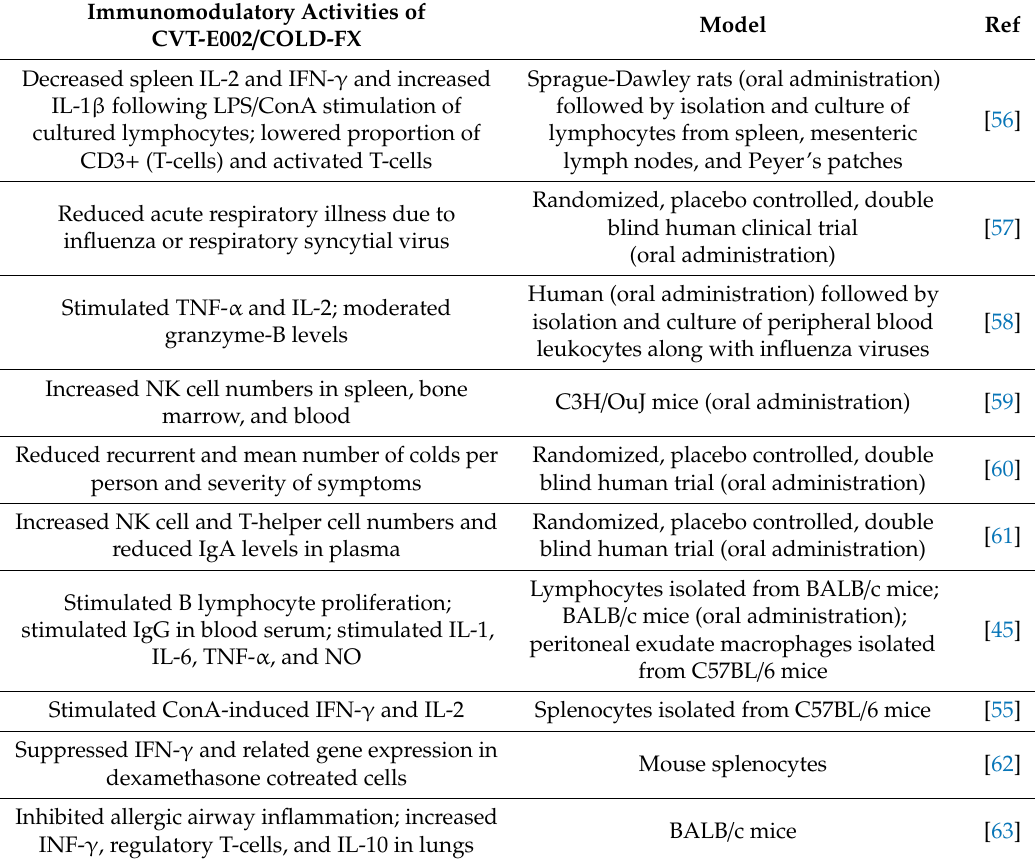
Table 3. Immunomodulatory activities of CVT-E002 /